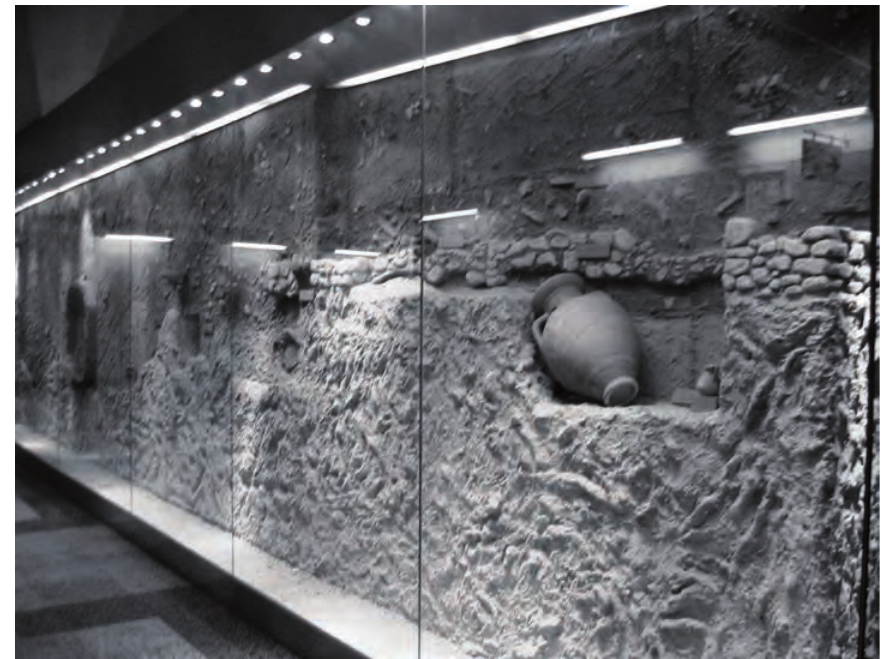
Figure 5. Dafni Metro Station: replica of the stratigraphy and some of the objects discovered during the construction of the Metropolitan Railway Station in Athens (Photo by K.